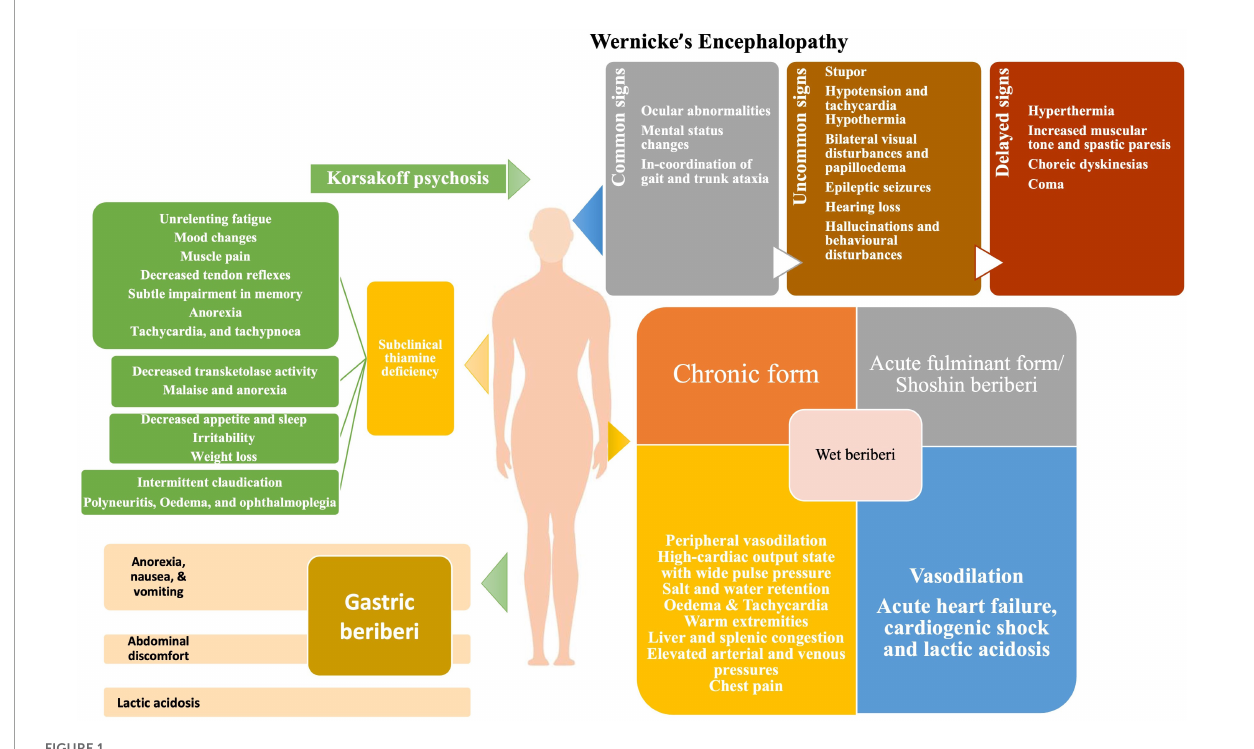
FIGURE1 Clinical manifestations of thiamine